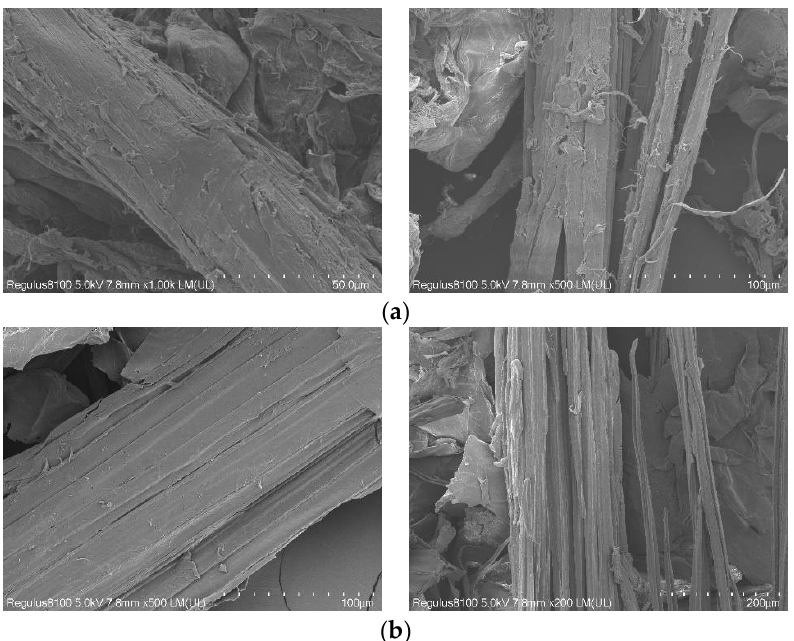
Figure 7. Scanning electron micrographs of crude cellulose AC ( a ) and crude cellulose HC ( b ).